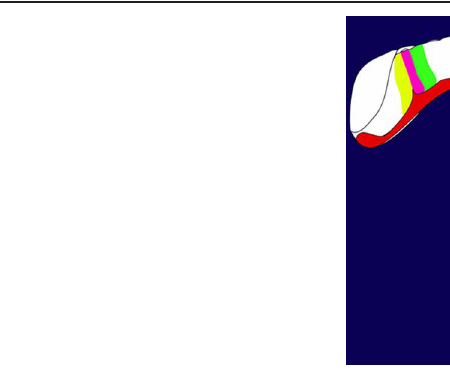
FIGURE 1 | Development of the thalamus in